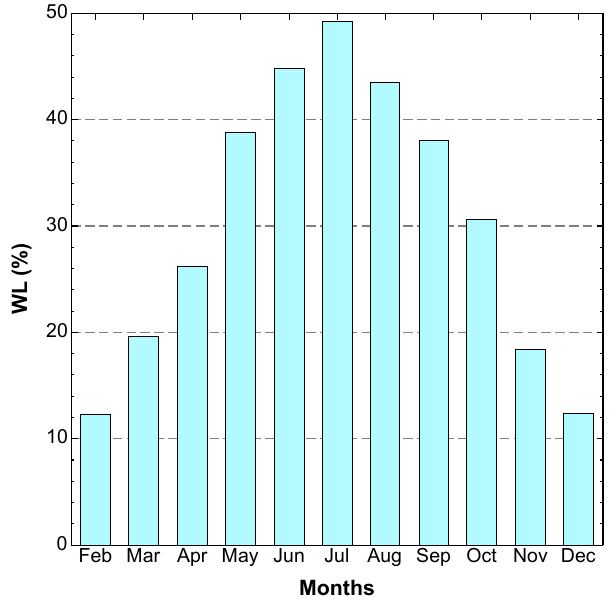
Figure 6. The total water loss for each month. Thus, the accommodation of canal-top PV systems promotes a higher quantity of water-saving. In this study, due to resource limitation, it was impossible to conduct on- site or laboratory experiments to estimate precisely the water quantity that can be